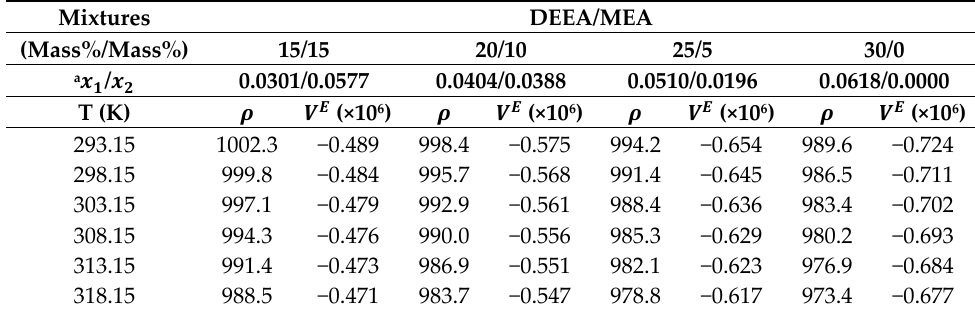
Table 5. Densities 𝜌 (kg · m −3 ) and excess molar volume 𝑉 𝐸 (m 3 · mol −1 ) of DEEA (1) + MEA (2) + H 2 O (3)